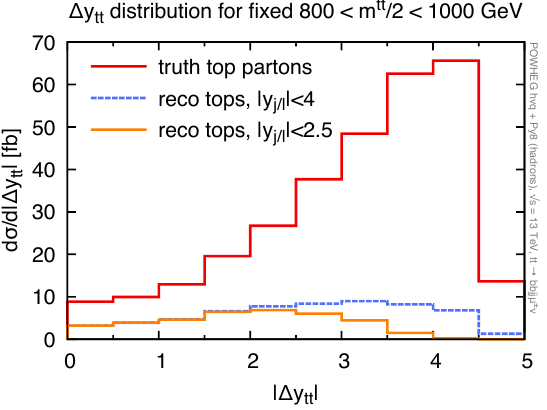
distribution with the distribution obtained t ¯ t